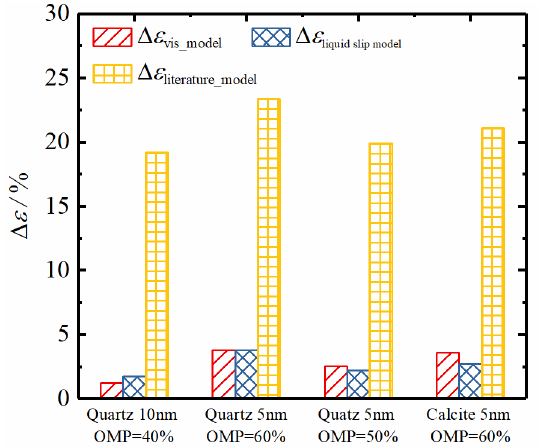
Figure 15. The comparison of relative error of flow rate calculated by various mathematical models in the various systems (driven force = 0.0035 kcal·mol −1 ·Å −1 ).